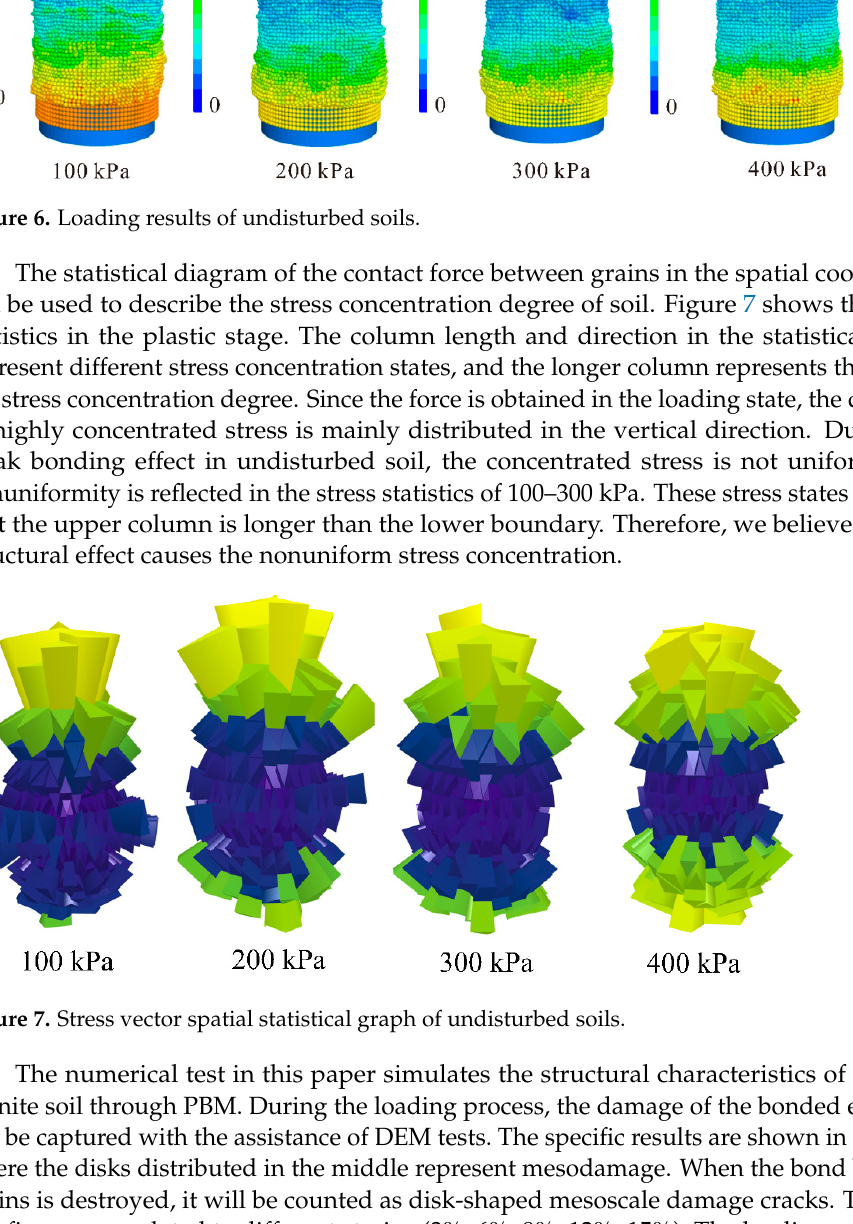
Figure 8. Crack development in undisturbed soil under 300 kPa confinement.